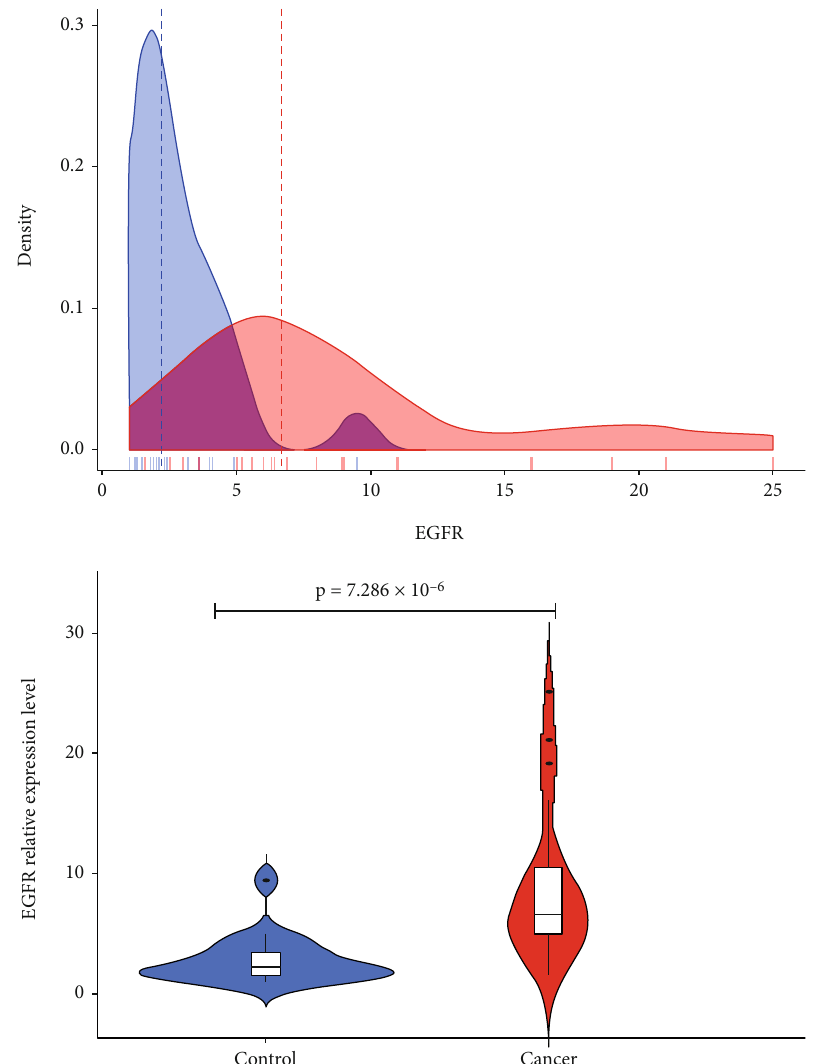
Figure 1: The levels of expression of the EGFR in head and neck tumor tissues were compared with their corresponding head and neck tissues by real-time PCR (polymerase chain